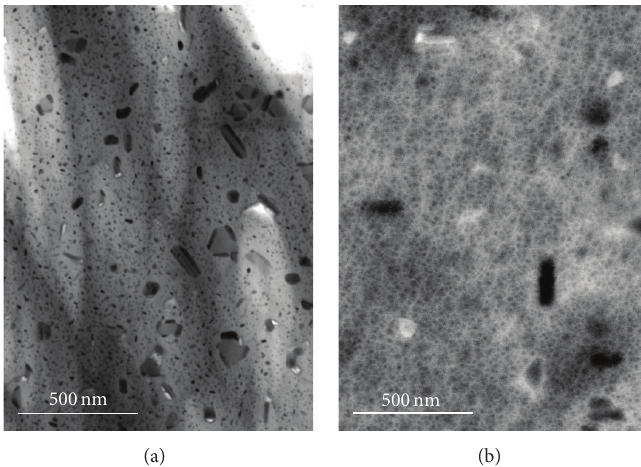
Figure 3: (a) LV-STEM image of IC particles in the grain interior of EN AW-7075 T73 and (b) SE image of a corresponding AAO film formed by potentiodynamic anodising of this alloy in 0.4M sulphuric acid showing typical pore mouths, voids caused by IC particle dissolution, and (transformed) IC particles embedded in the film.